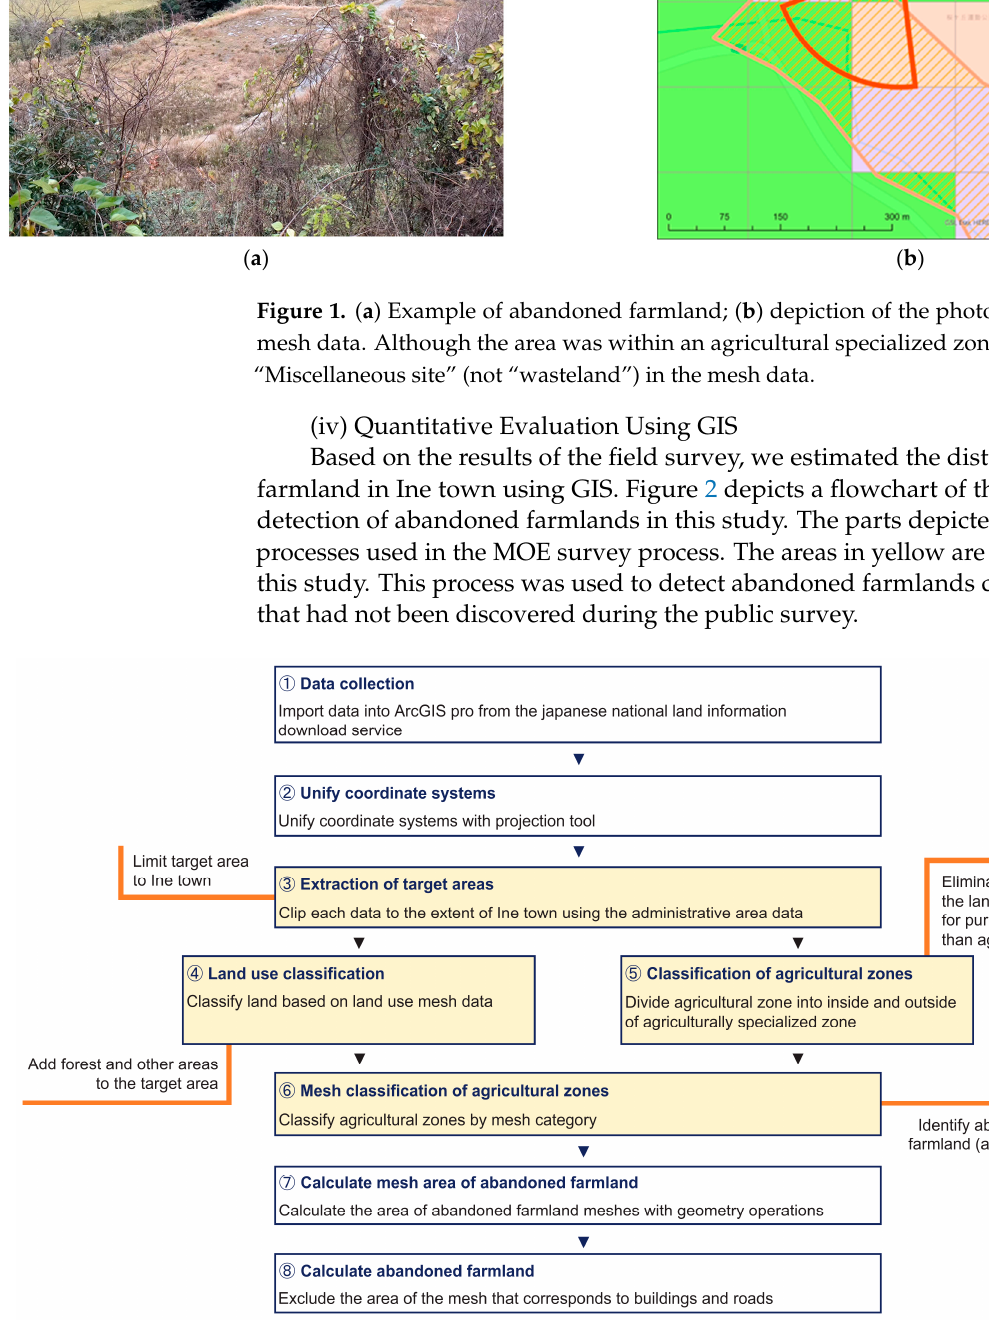
Figure 2. Flowchart of the process used for the detection of abandoned land in this study. Table 4. Vector dataset used to detect abandoned farmland